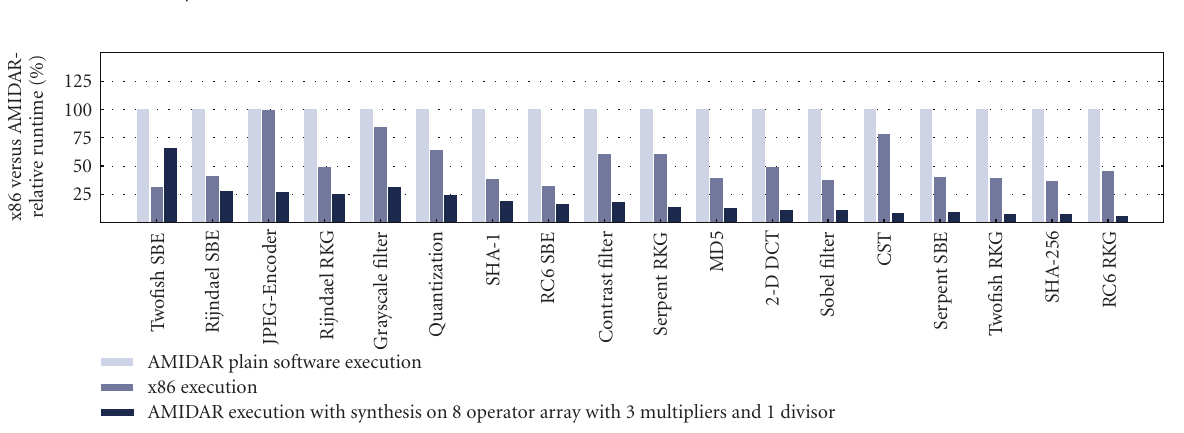
only a small number of three benchmarks benefit from the additional memory access